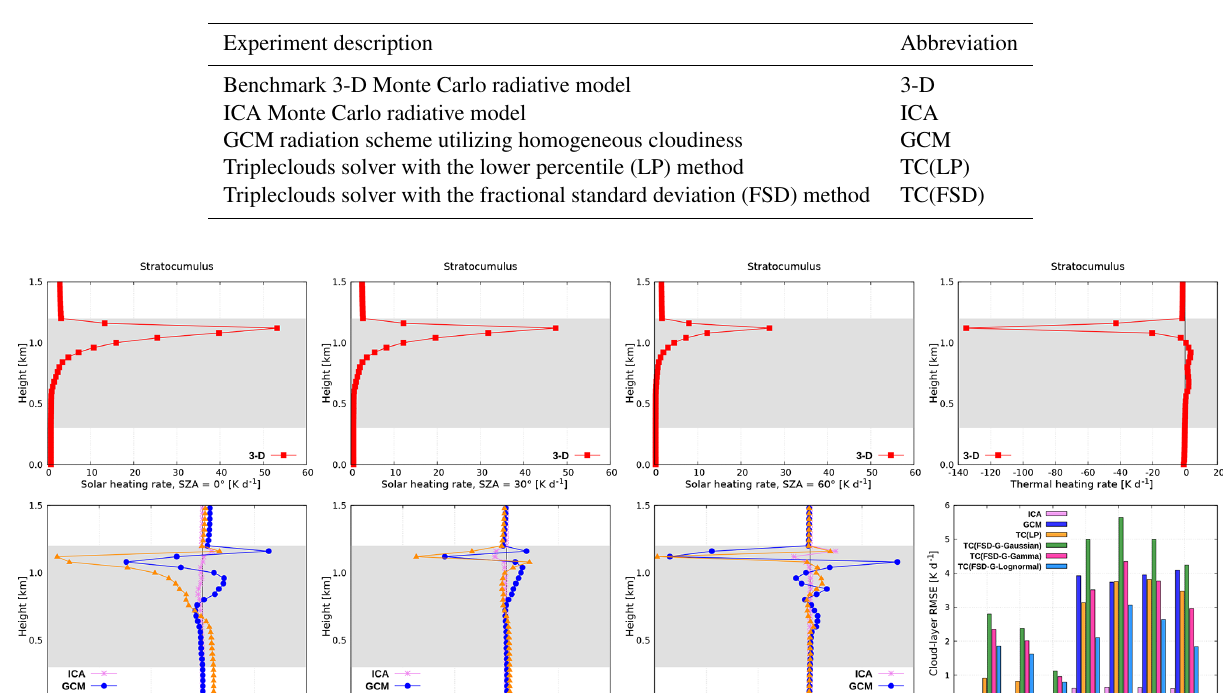
Table 1. List of radiative transfer experiments.